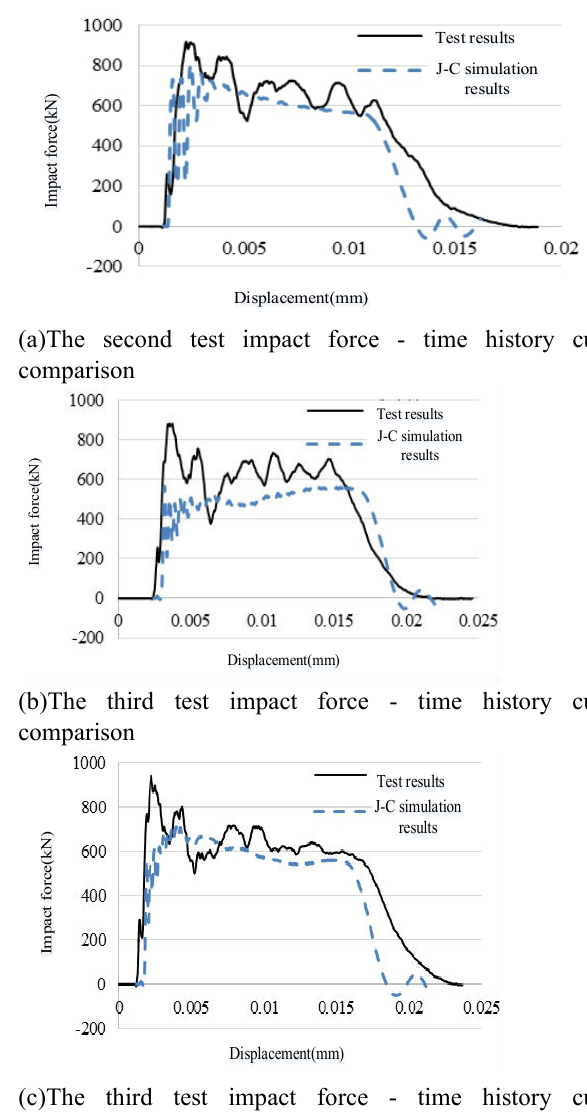
Figure 11. Impact-time history curve of J-C constitutive